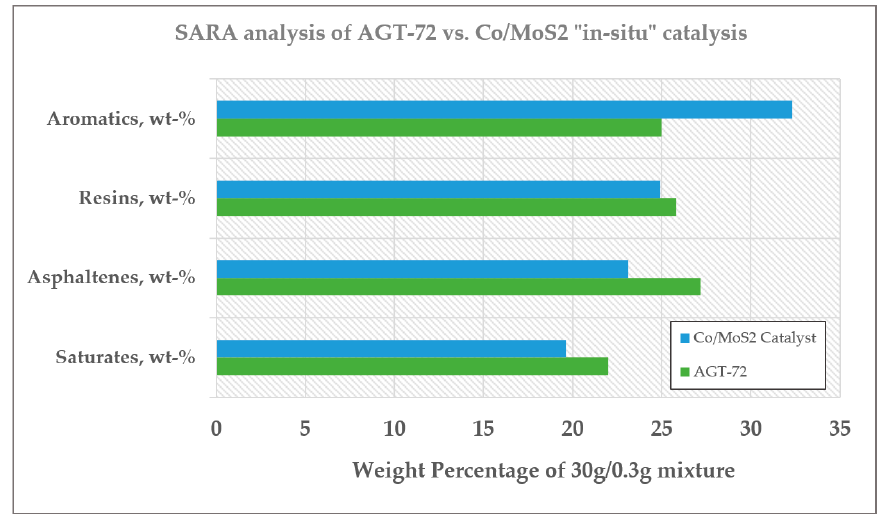
Figure 3. SARA analysis of AGT-72 before and after hydroprocessing with Co/MoS 2 catalyst at 350 °C for 8 h.